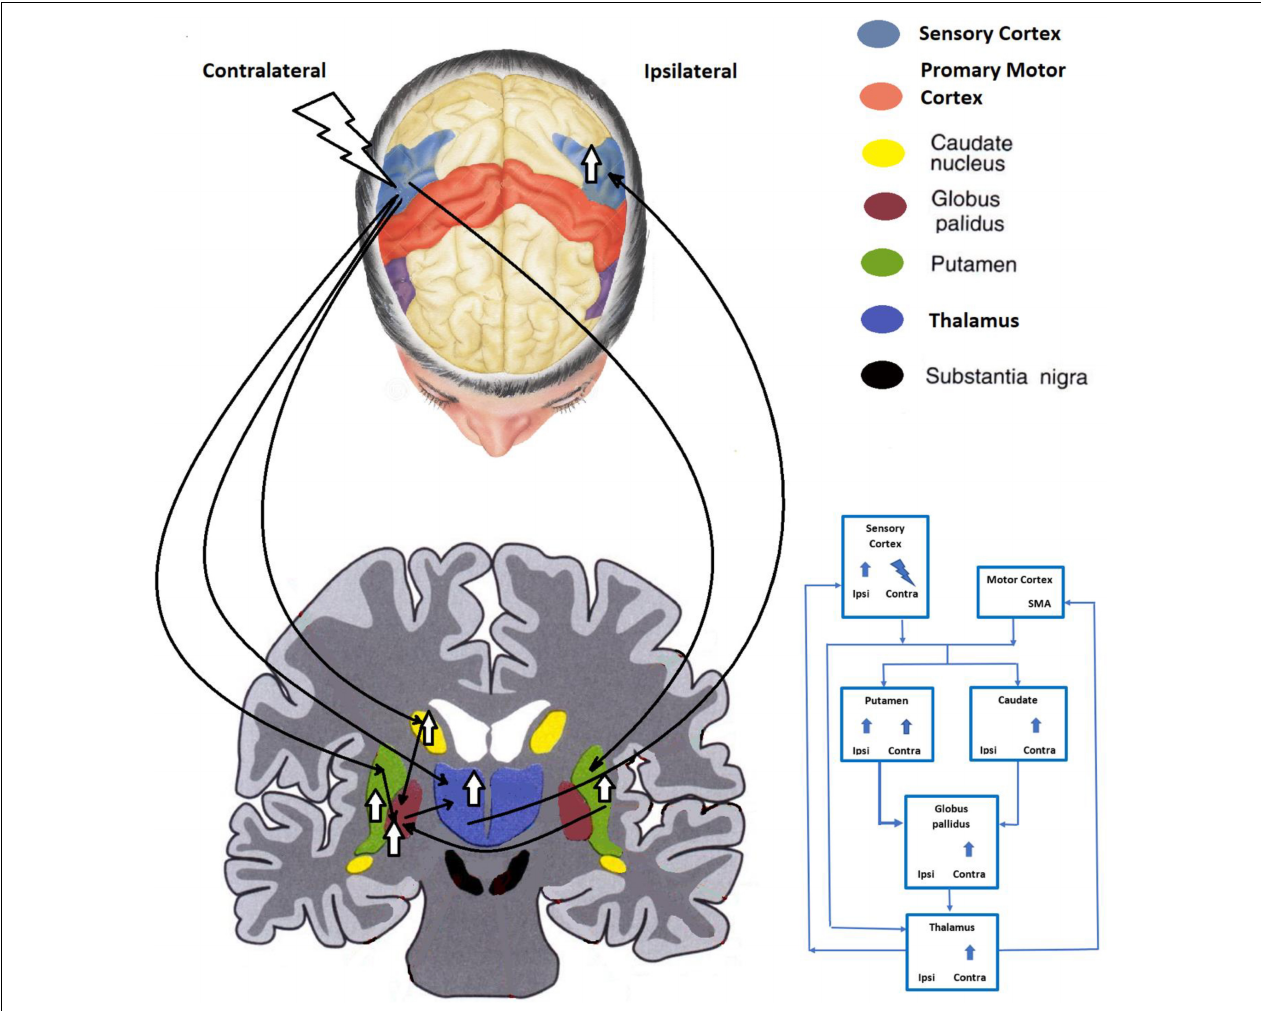
FIGURE 2 | The proposed cathodic tDCS modulation pathway of the contralateral sensory